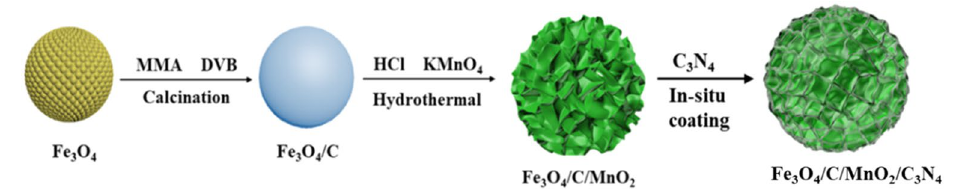
Figure 1. Fabrication of magnetic flower-like Fe 3 O 4 /C/MnO 2 /C 3 N 4